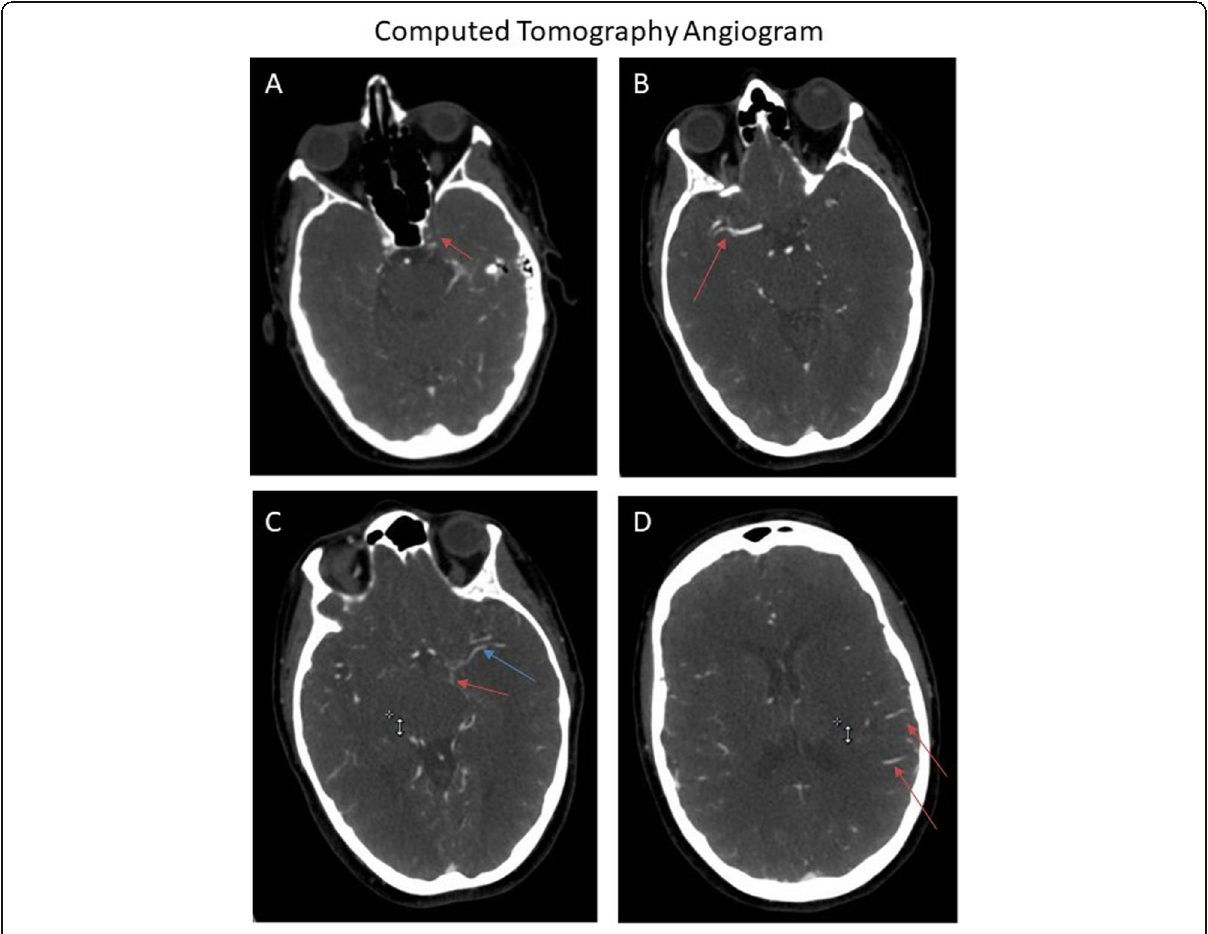
Fig. 2 Computed tomography angiogram. Presenting computed tomography-angiographic study showing complete occlusion of left intracranial portion of the internal carotid artery at the level of carotid terminus (red arrow) ( a ). Compared to the patent right middle cerebral artery (MCA) ( b ), there was trace opacification of left MCA branches (blue arrow) by left posterior communication artery (red arrow) ( c ), with minimal reconstitution peripherally by the leptomeningeal (red arrows) ( d